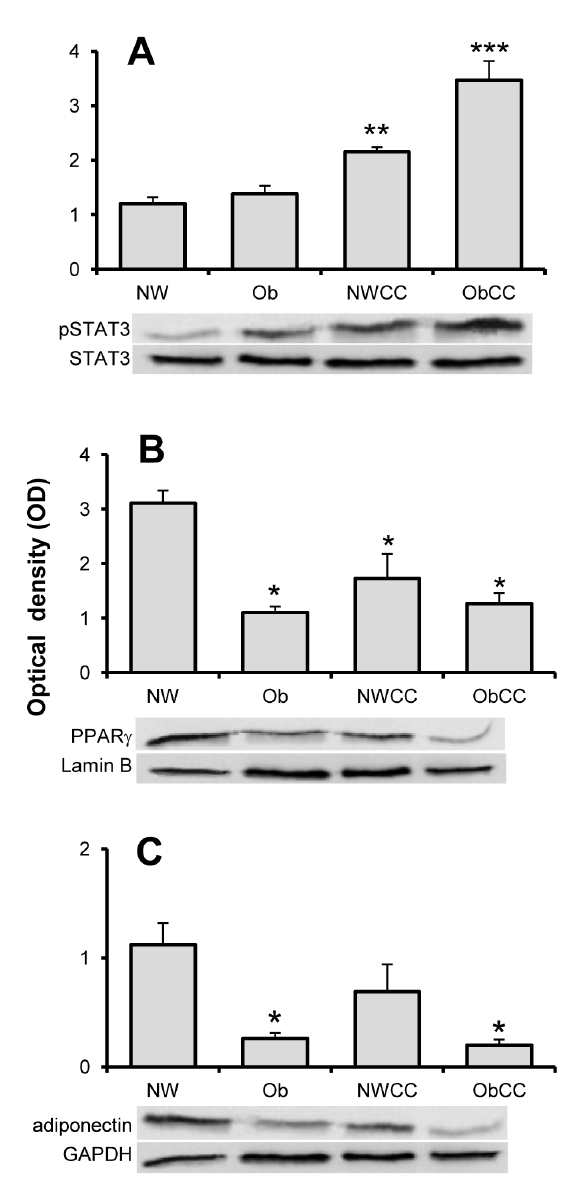
Figure 1. Immunoblotting analysis of pSTAT3, PPARγ, and adiponectin. Human visceral adipocytes, collected from the four groups of subjects, were serum-starved for 18 h. Whole cell extracts and nuclear protein extracts were separated by SDS-PAGE and analyzed using anti-pSTAT3 (A), anti-PPARγ (B) and anti-adiponectin (C) antibodies. Results were normalized to STAT3, Lamin B and GAPDH protein content, respectively. NW: normal weight subjects (n=5); Ob: overweight/obese subjects (n=5); NWCC: normal weight with colorectal cancer (n=7); ObCC: overweight/obese with colorectal cancer (n=7). The data are expressed as means ± SEM. *, P<0.05 compared with NW; **, P<0.05 compared with NW and Ob; ***, P<0.05 compared with NW, Ob, and NWCC. Representative blots are shown.